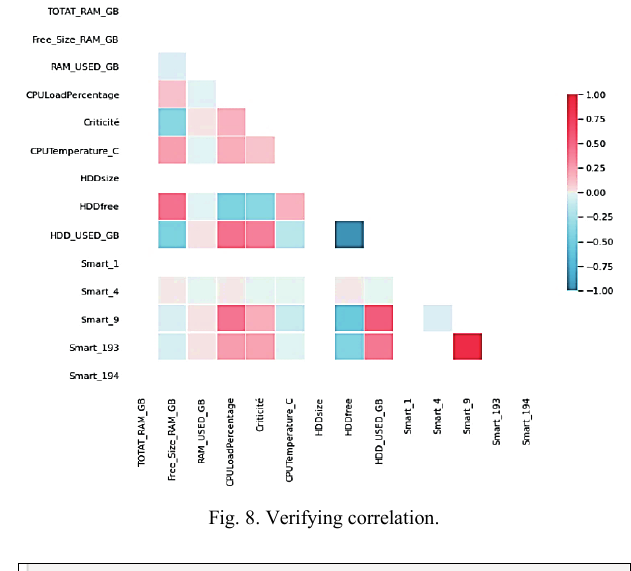
Fig. 8. Verifying correlation.